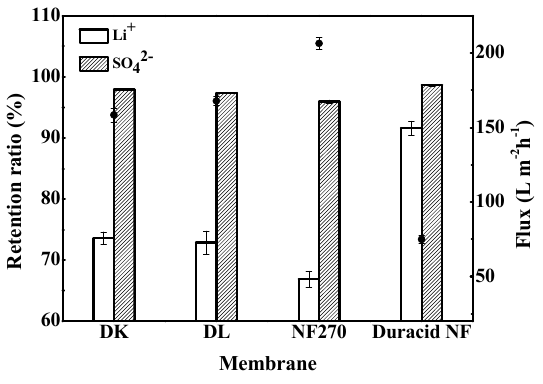
Figure 9. Retention ratio of Li + and SO 42 − and flux of four NF membranes.